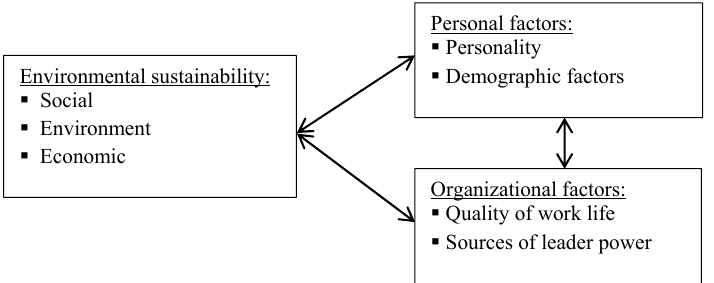
Fig. 2: The research model of the current study